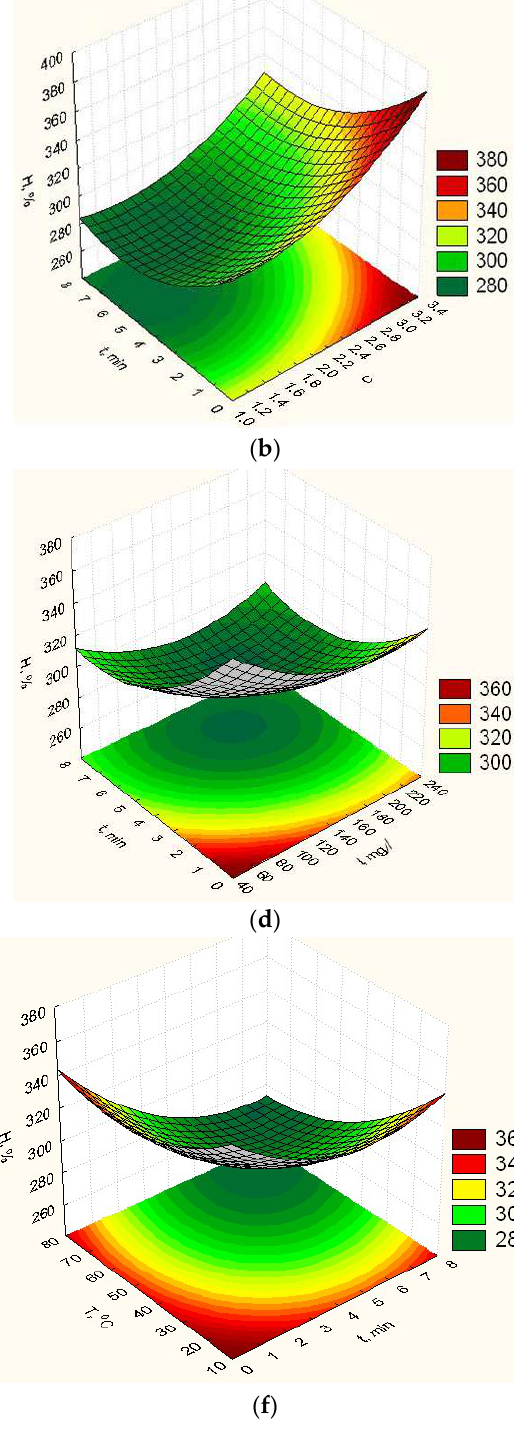
Figure A2. Response surfaces of the dependence of the swelling of the film on the composition and technological parameters of its manufacture: ( a )— С , І , t = 4 min, T = 46 °C; ( b )— С , І = 140 mg/l, t , T = 46 °C; ( c )— С , І = 140 mg/l, t = 4 min, T ; ( d )— С = 2.2, І , t , T = 46 ° C; ( e )— С = 2.2, І , t = 4 min, T ; ( f )— С = 2.2, І = 140 mg/l, t , T .